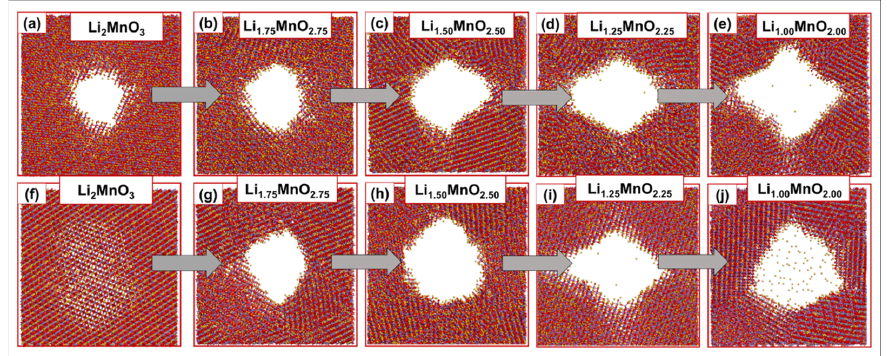
Figure 3. Molecular graphics of the crystallised Li 2 − x MnO 3 − x ( a – e ) nanoporous 75 Å and ( f – j ) nanoporous 73 Å, with different Li/O concentrations.